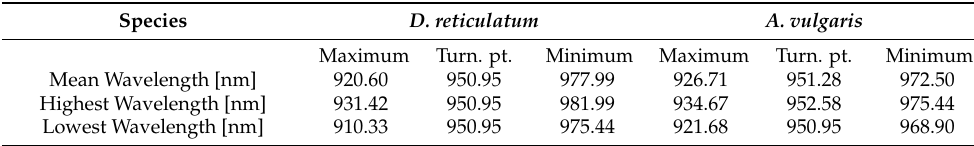
again in the VNIR range. The maxima of the relative reflectance of the slugs were meas- ured between wavelengths of 910.33 nm and 934.67 nm. Additionally, the minima of the relative reflectance were measured between 968.90 nm and 981.99 nm. The exact positions of the extrema depended on the species and the individual slug. The low dispersions at the measured turning points were conspicuous. These were all in a very narrow band, Table 2. Exact points of the extrema determined for the slugs and the ranges of the results. in Table 2.